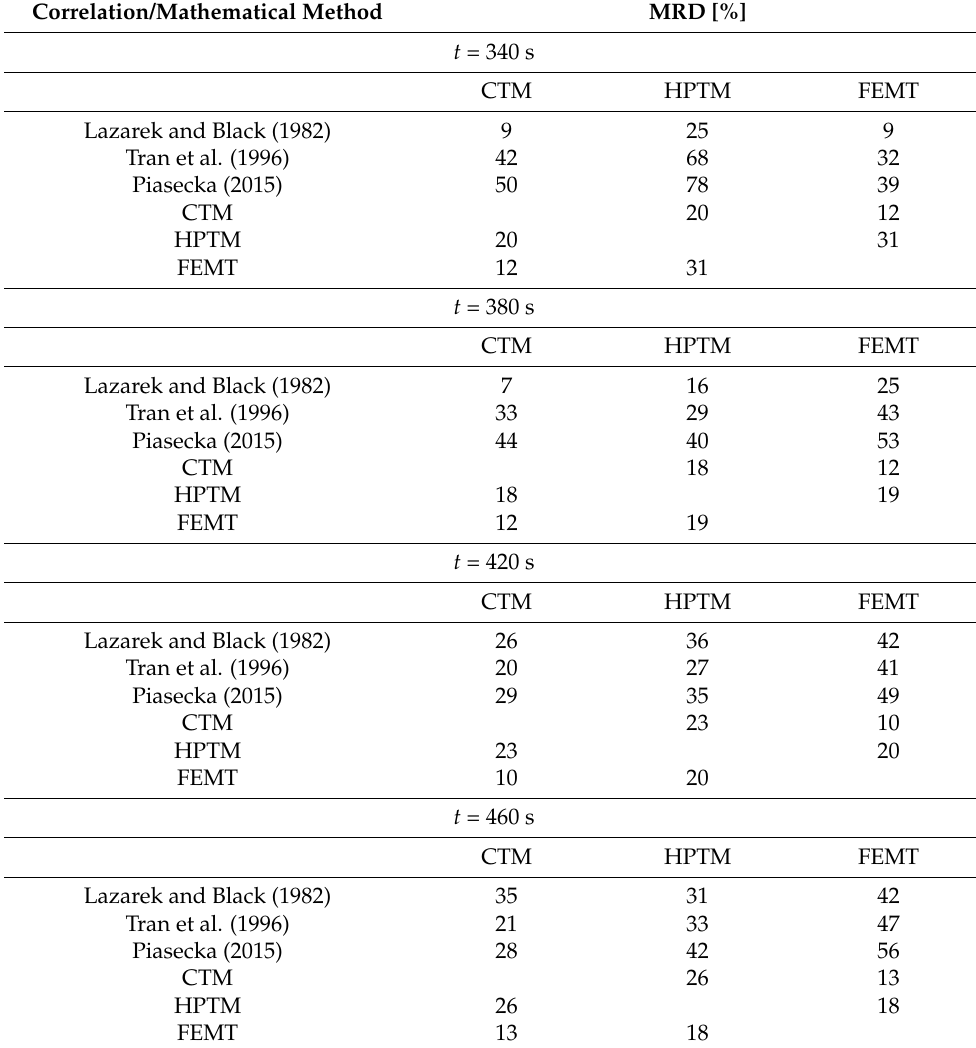
Table 5. Maximum relative differences (MRD) between heat transfer coefficient values calculated from the proposed mathematical methods and selected theoretical correlations at four time